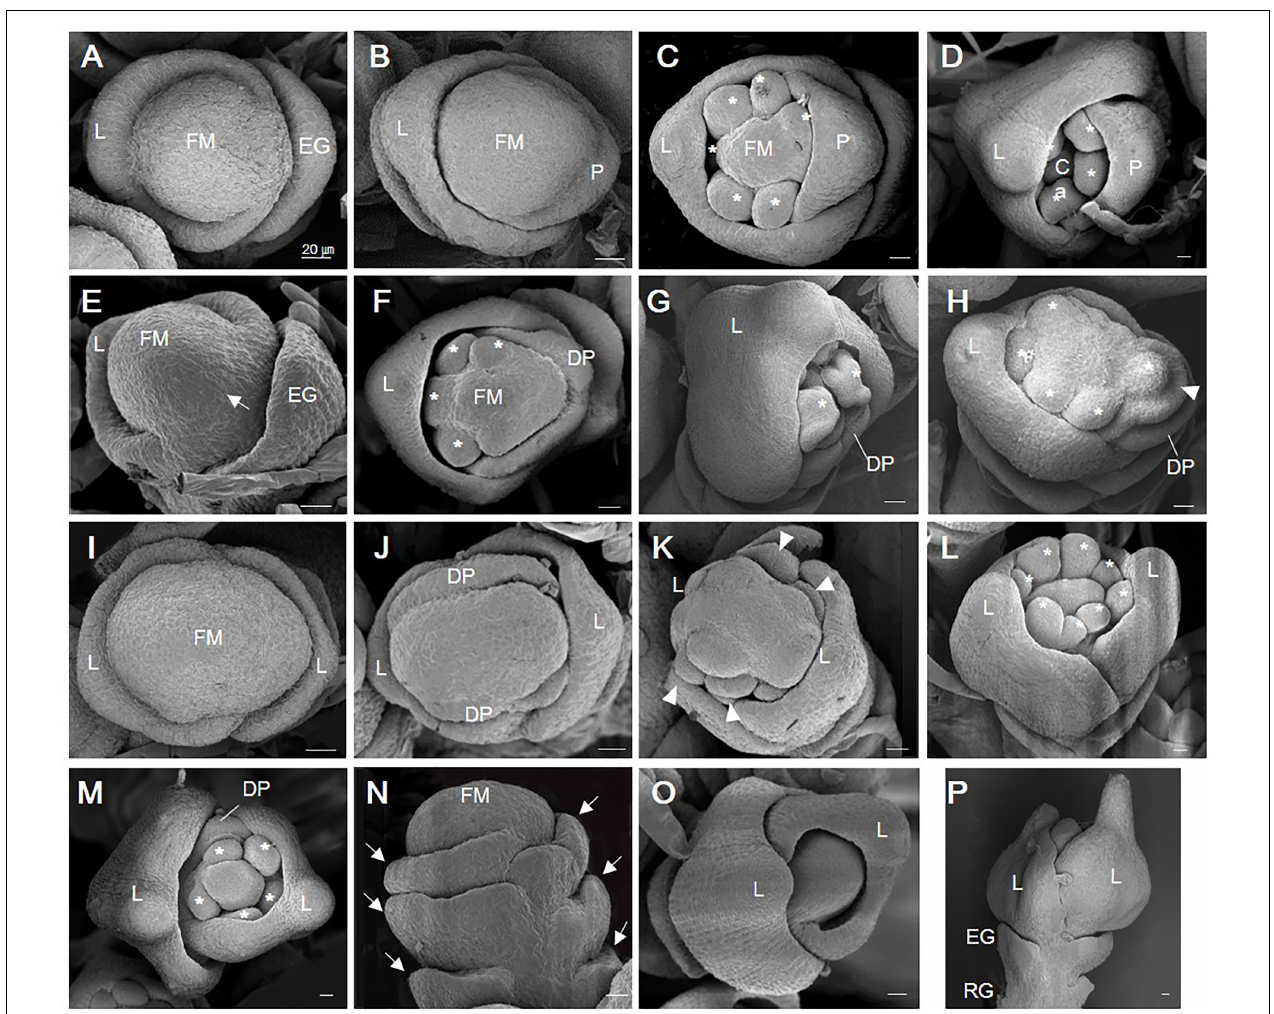
FIGURE 3 | Scanning electron micrographic images of WT and osvil2 spikelets during early developmental stages. (A–D) WT spikelets. (A) Stage Sp3 during lemma primordia formation. (B) Stage Sp4-5 of palea primordia formation; possibly two lodicule primordia are initiating inside lemma. (C) Stage Sp6, with formation of six stamen primordia (asterisk). (D) Stage Sp8, with carpel primordia initiation during growth of lemma and palea. (E–H) Retarded palea growth in osvil2 spikelets. (E) Stage Sp4, showing retardation of palea primordia (arrow) when compared with lemma growth. (F) Stage Sp6, with degenerated palea formation and retarded stamen primordia formation on palea side. (G) Stage Sp8, with retarded growth of palea compared with lemma. (H) Stage Sp6, showing formation of stamen primordia (asterisk) in irregular pattern. Additional organ primordia (arrow head) between palea and stamen, increasing size of floral whorl. (I–L) osvil2 spikelet with twin-flower phenotype. (I) Stage Sp3, with wider floral meristem and two lemma primordia on both sides. (J) Stage Sp4, with two degenerated palea primordia forming in middle of two lemma. (K) Stage Sp6, representing ectopic organ primordia (arrow heads) likely to produce additional palea and lodicules. (L) Stage Sp6-7, with eight stamen primordia produced. (M–P) osvil2 spikelet with additional glume or lemma-like organs. (M) Stage Sp7, in which number of stamen primordia is reduced to 5. Floral whorls are increased and degenerated palea form after additional lemma. (N) Stage Sp4, with formation of additional glume primordia (arrows). (O) Stage Sp6, in which additional lemma are produced while inner organ formation is delayed. (P) Stage Sp8, with additional lemma produced after formation of normal empty glumes and rudimentary glumes. Ca, carpel; DP, degenerated palea; EG, empty glume; FM, floral meristem; L, lemma; P, palea; RG, rudimentary glume. Scale bars = 20 µ